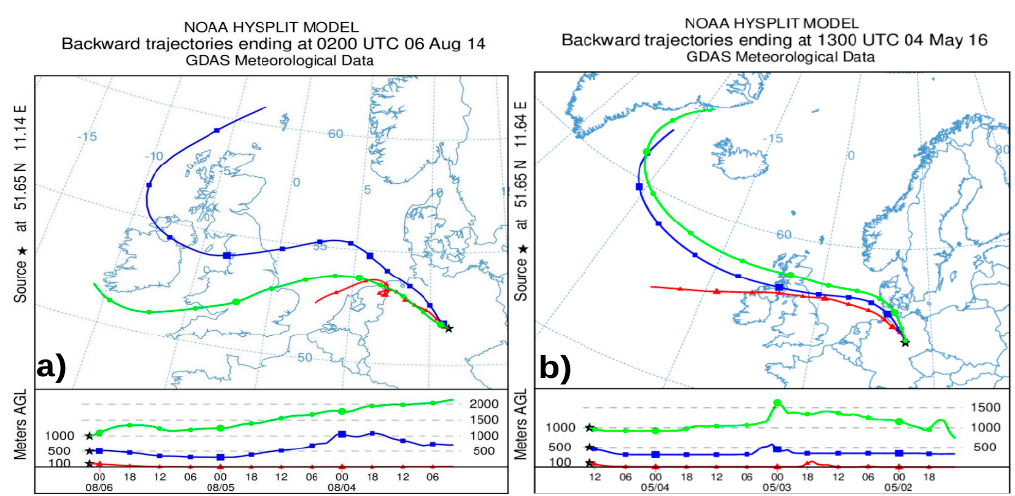
Figure 8. HYSPLIT backward trajectories run over 72 h for CALIOP’s overpasses at Harzgerode on ( a ) Cloud–free case, 06/08/14 at 01:39:59 UTC ( b ) Case with a thin cloud, 04/05/16 at 12:20:44 UTC.